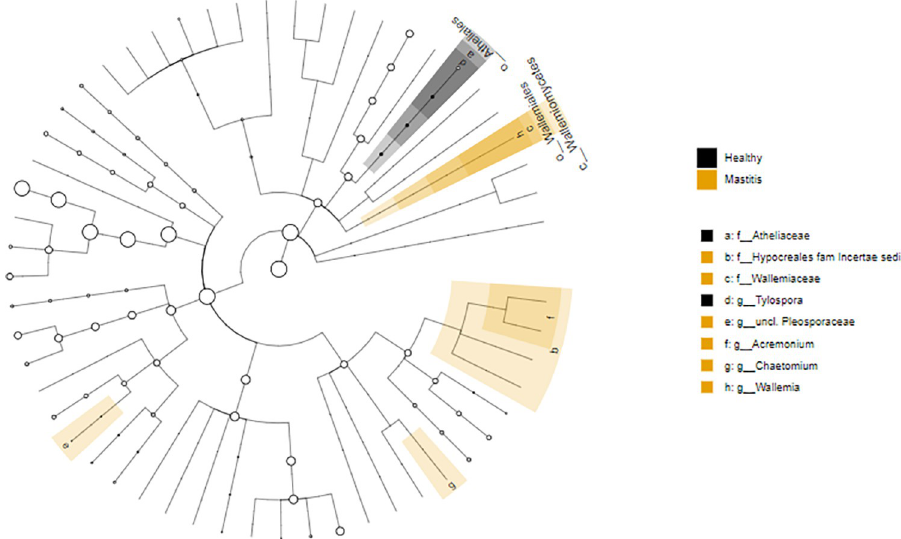
Fig 8. Cladogram of the top ten marker taxa per sample group corresponding to healthy and mastitis samples for the ITS.